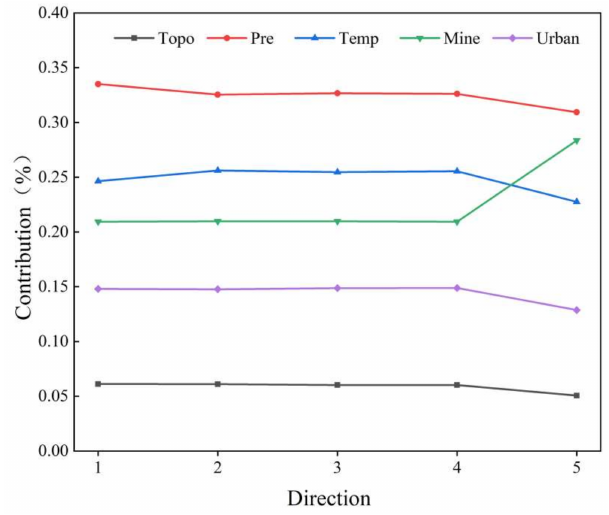
Figure 11. The contribution of driving factors in different